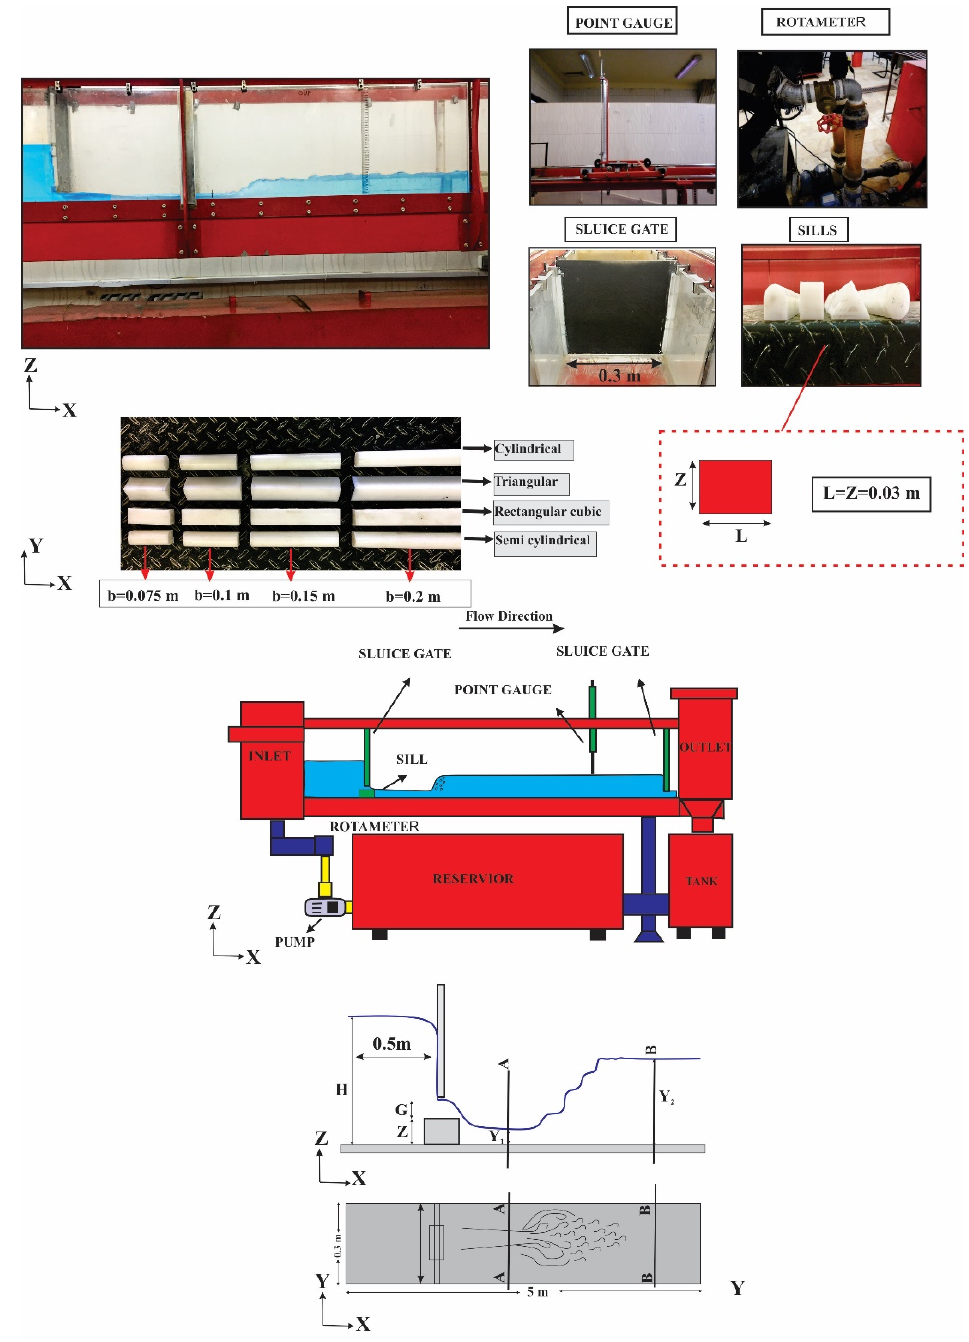
Figure 1. Schematic view of the channel and sills used in the present study. Table 1. Physical characteristics of the sills used in this study.